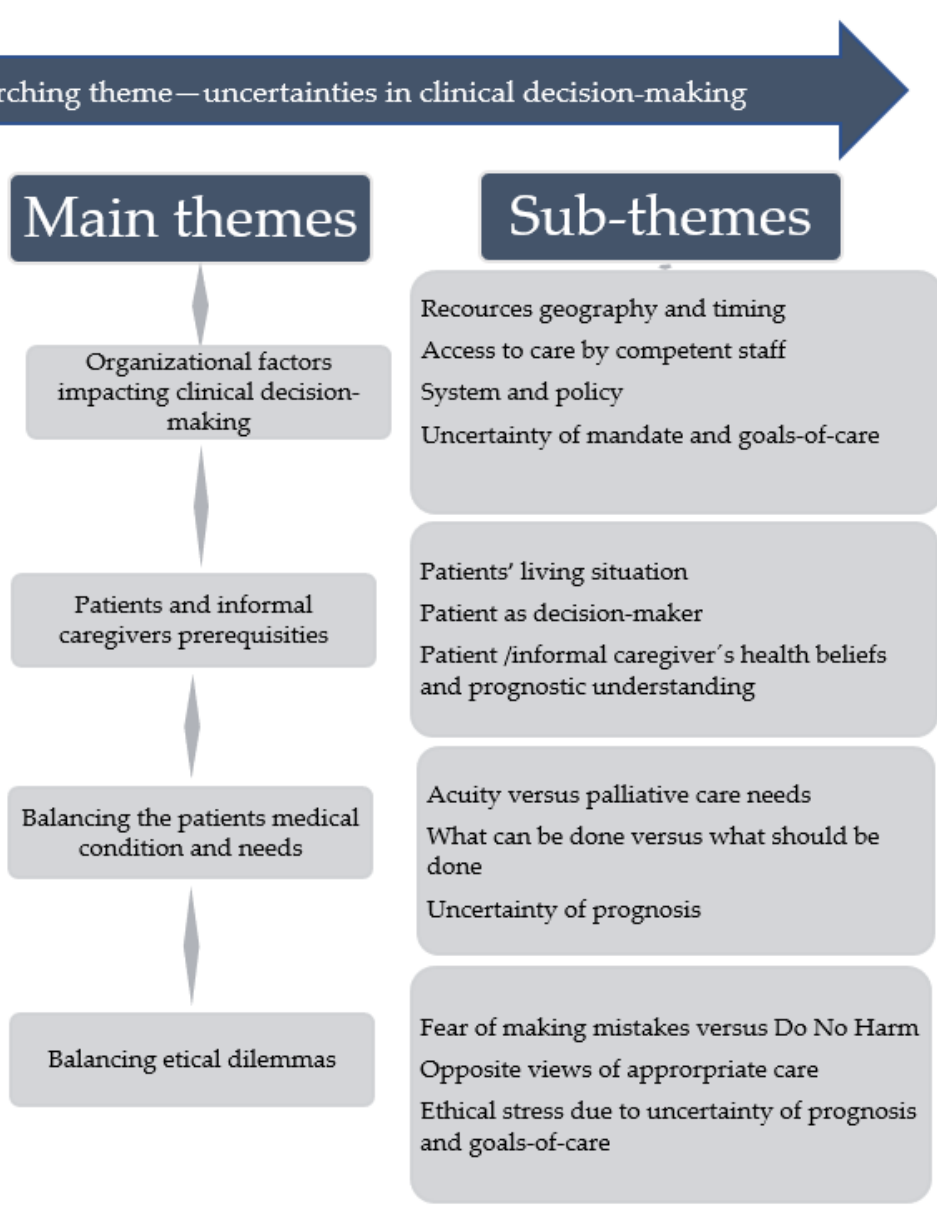
Figure 2. The overarching theme, main themes, and